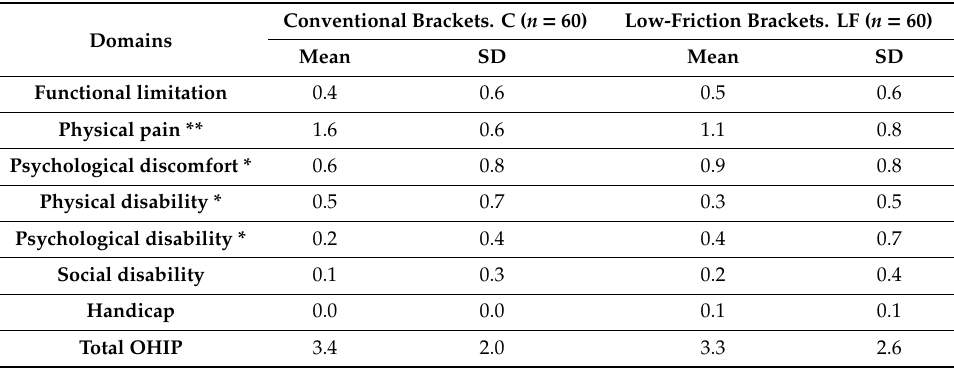
Table 5. Comparison of quality of life measures between treatment groups ( n = 120). Conventional Brackets. C ( n = 60) Low-Friction Brackets. LF ( n = 60) Domains Mean SD Mean SD Functional